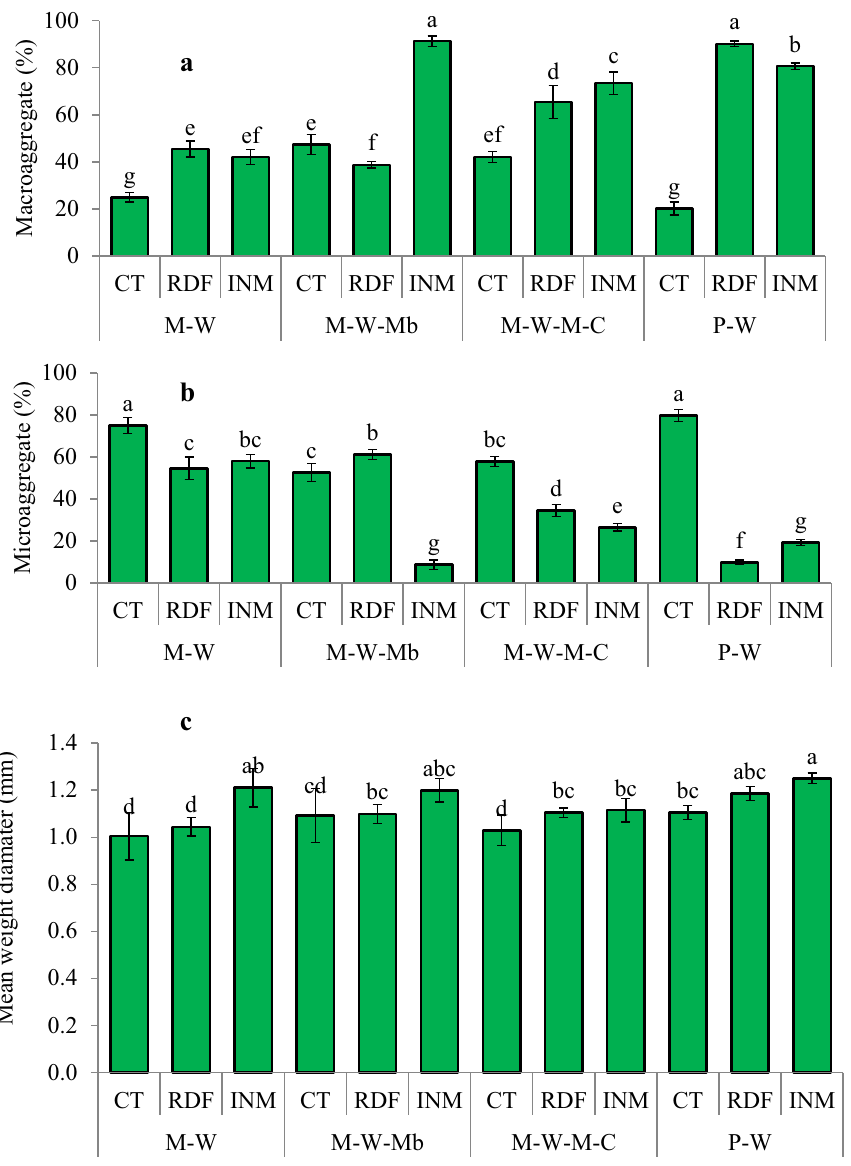
Figure 1. Impact of management practices on aggregate properties after 14 years; lowercase letters (a–g) delineates significant difference at p ≤ 0.05 using Tukey’s honest significance